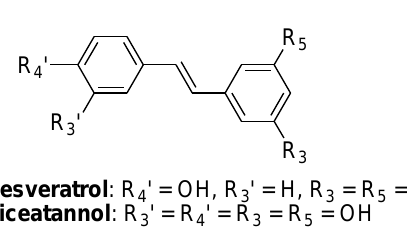
FIGURE 1. Structure of the most common natural stilbenes.